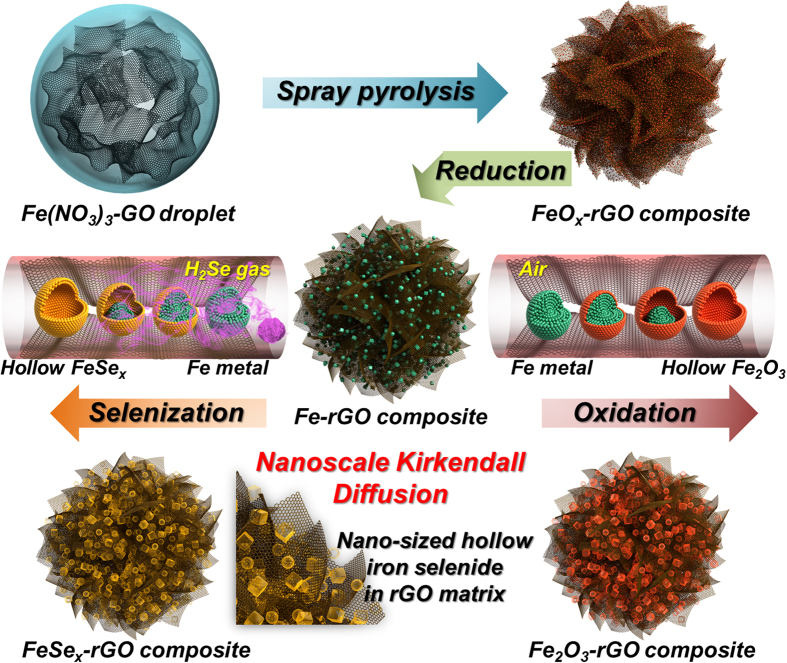
Formation mechanism of the hollow FeSex nanoparticles- and the hollow Fe2O3 nanoparticles-decorated rGO composite powders by nanoscale Kirkendall diffusion.